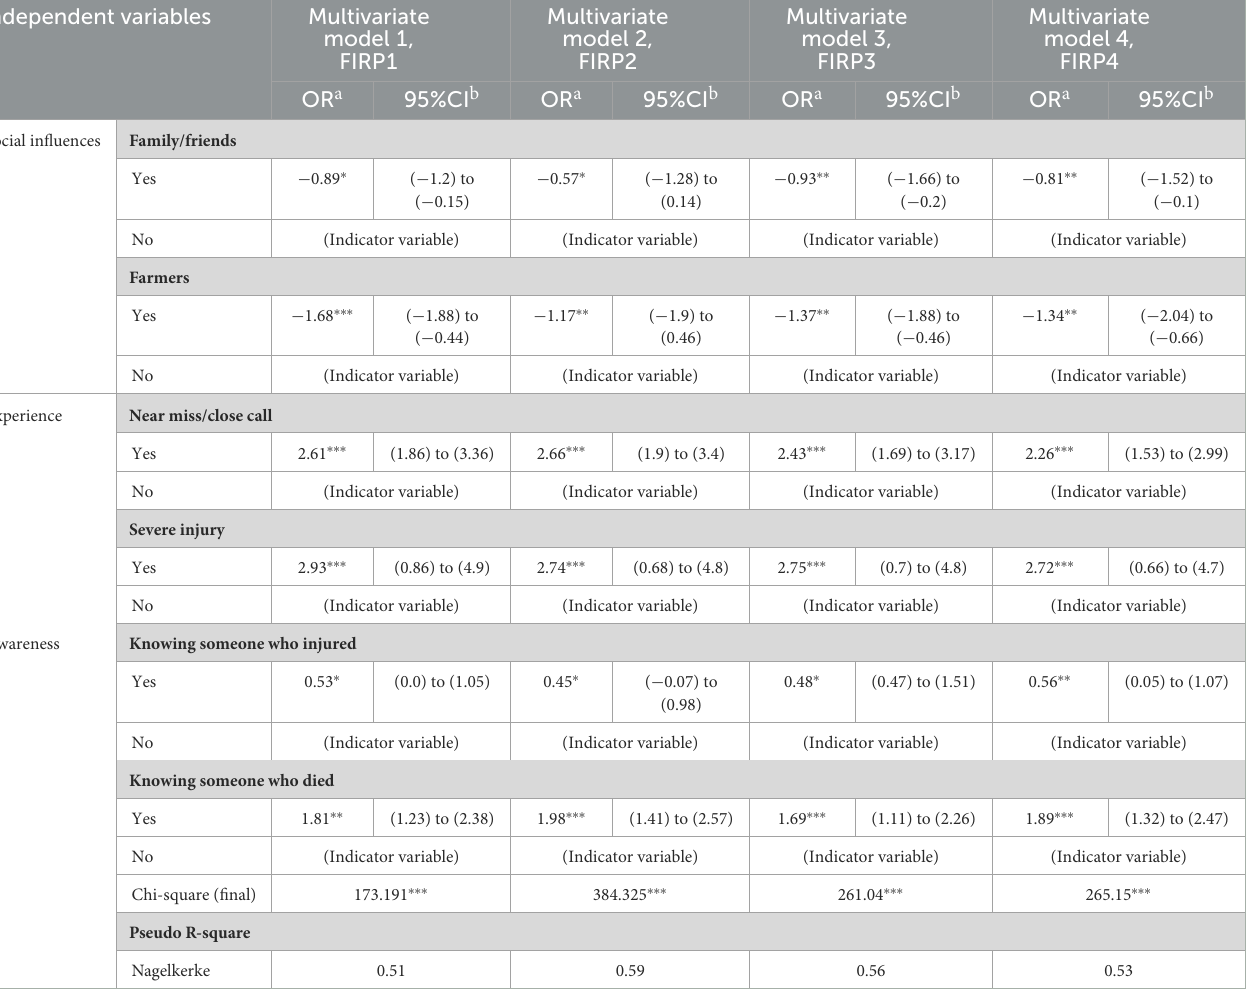
TABLE 5 Ordinal Logistic Regression analysis between explanatory variables and FIRPs. Independent